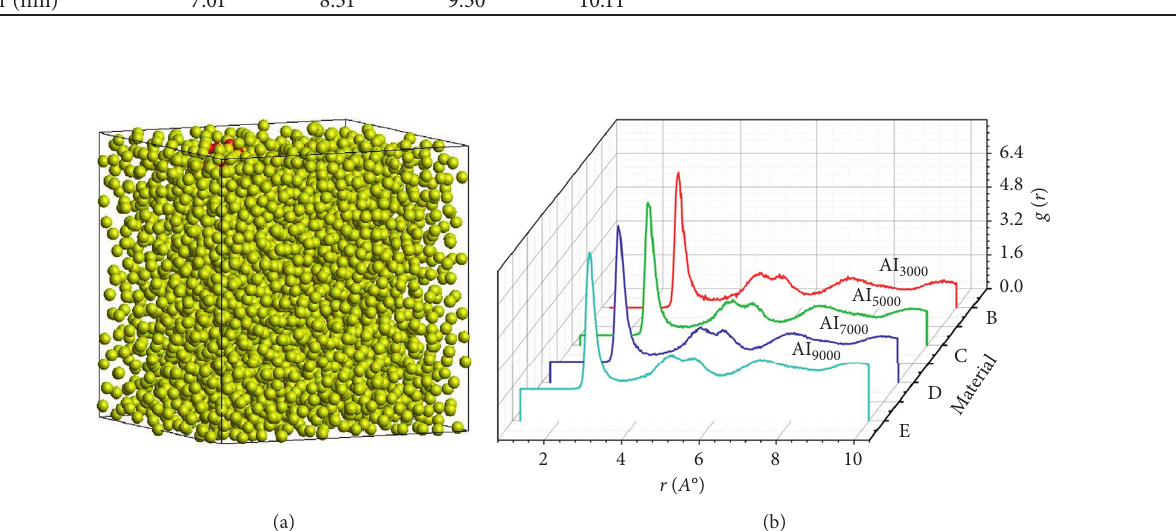
Figure 1: The shape of the bulk aluminium sample with 3000 atoms (a). Radial distribution function of the bulk aluminium sample with different numbers of atoms (b).